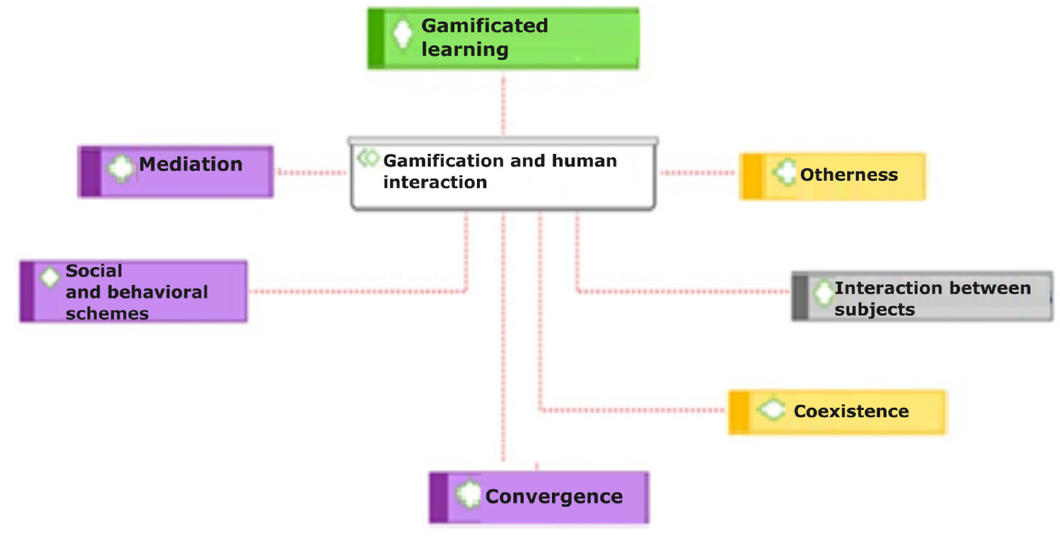
Figure 7. Edutainment network and human interaction. Source: Self-generated with the use of ATLAS.ti Software.